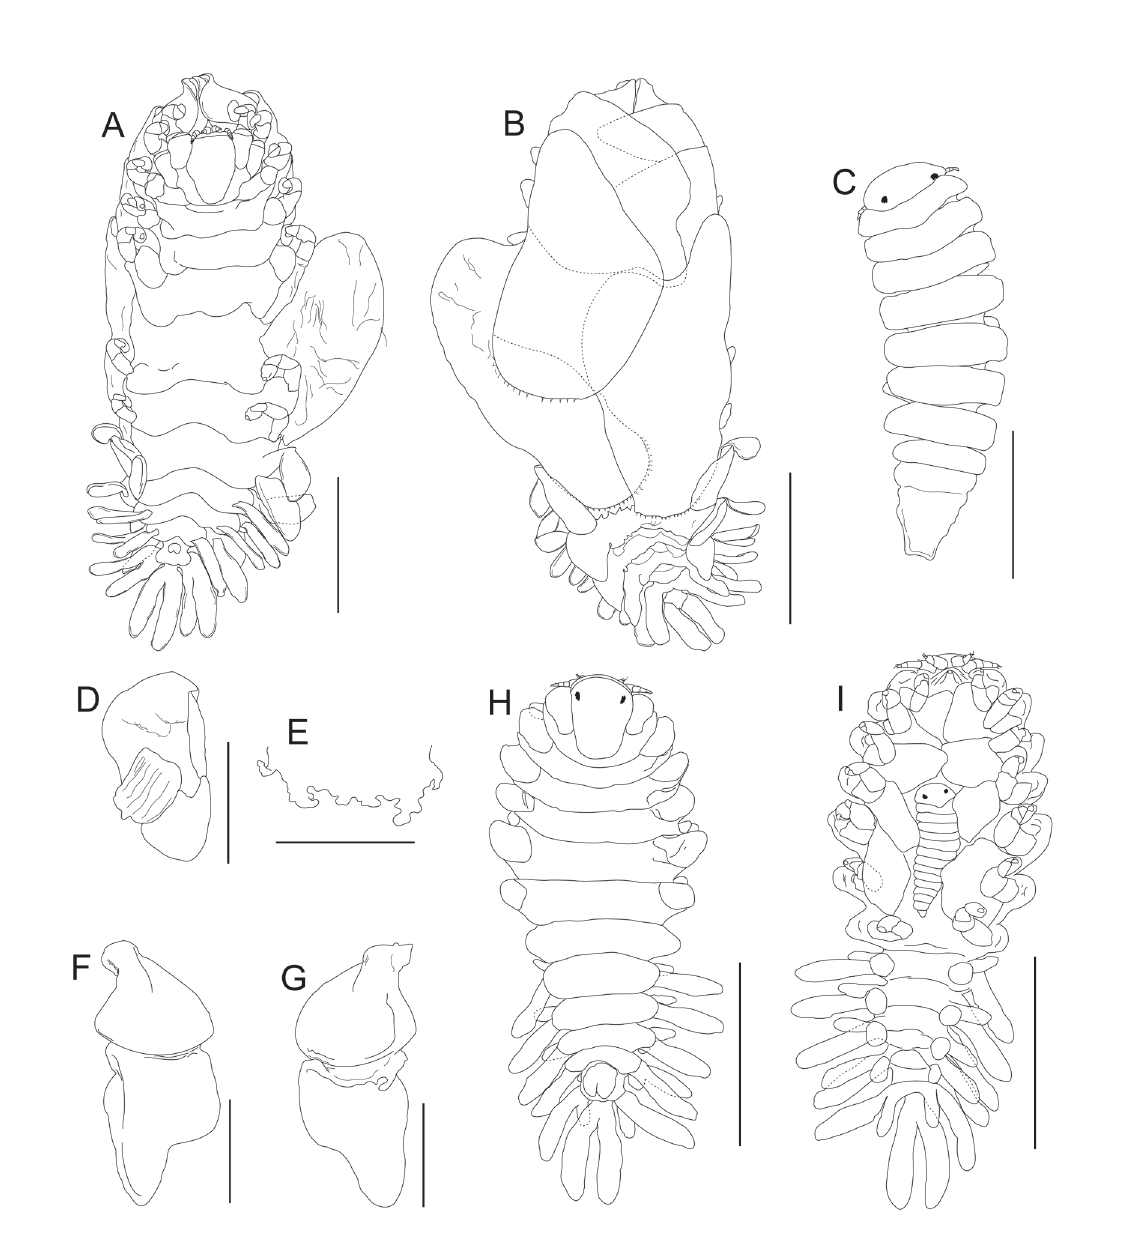
Fig. 4. Pseudostegias atlantica Lemos de Castro, 1965. A . Ovigerous ♀, dorsal view (CNCR-36485). B . Same ventral view. C . ♂, dorsal view (CNCR-36485). D . Maxilliped. E . Barbula. F . First oostegite, external view. G . Same, internal view. H . Juvenile ♀, dorsal view (CNCR-36482). I . Same, with cryptoniscus larva attached between oostegites, ventral view. Scale bars: A–B, H–I = 1.0 mm; C–G = 0.5